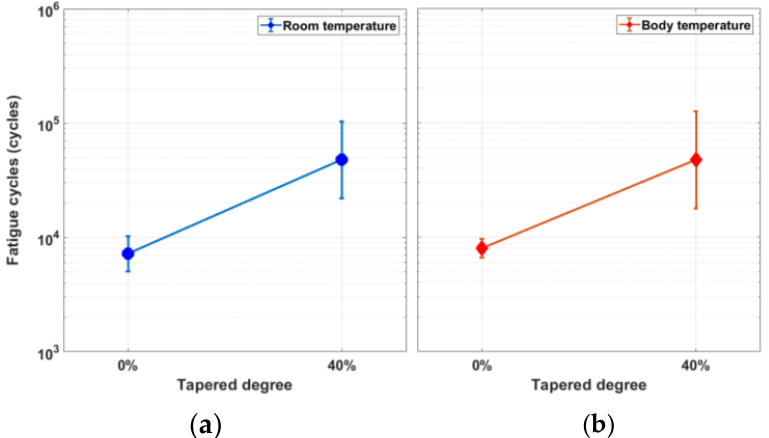
Figure 12. Fatigue cycle number comparison between standard design and 40% tapered-strut design at room temperature ( a ) and body temperature ( b ).